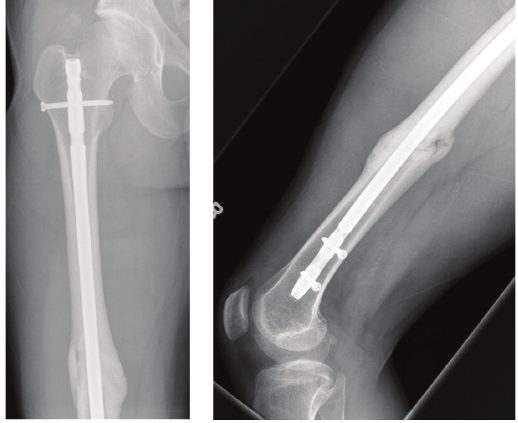
Figure 4: Intraoperative photograph illustrating the position of the Steinmann pins to achieve the necessary rotational correction. Figure 5: Anteroposterior and lateral radiographs illustrating ade- quate callus formation at the fracture site at time of final